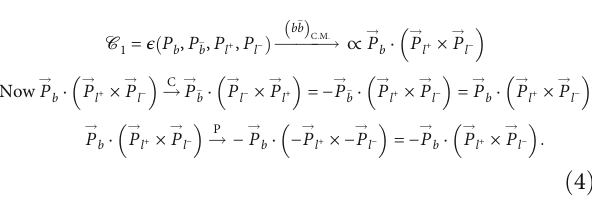
ffiffiffi p at = 13TeV energy at LHC for an integrated luminosity of (a) 36 : 1 fb − 1 and (b) 140fb − 1 S 5